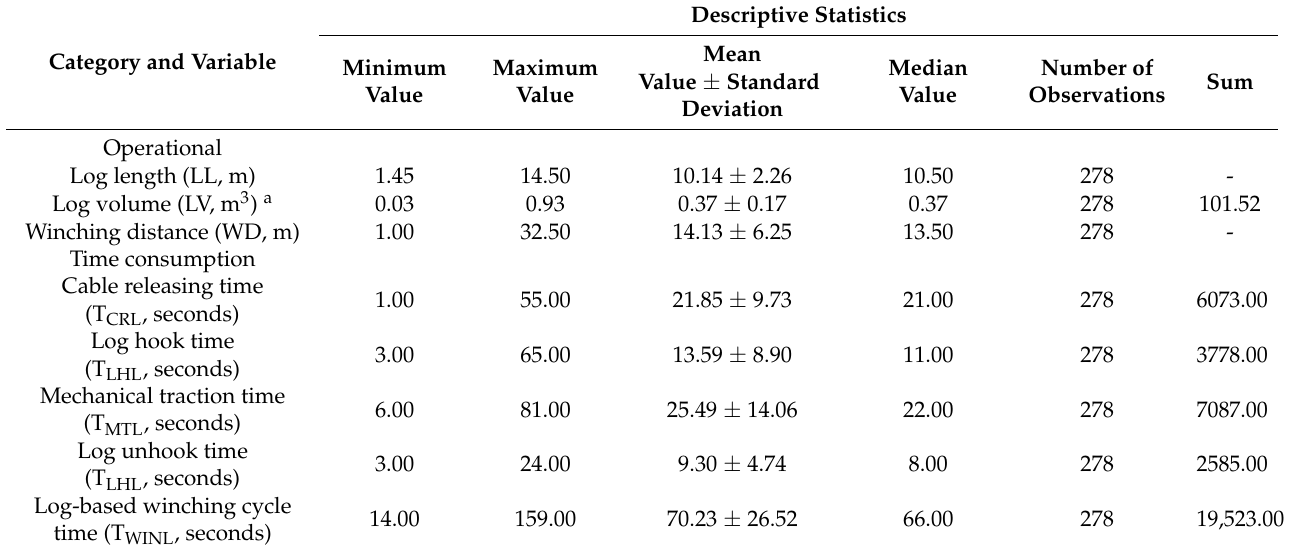
Table 4. Descriptive statistics of operational and time consumption variables for log-based winching.